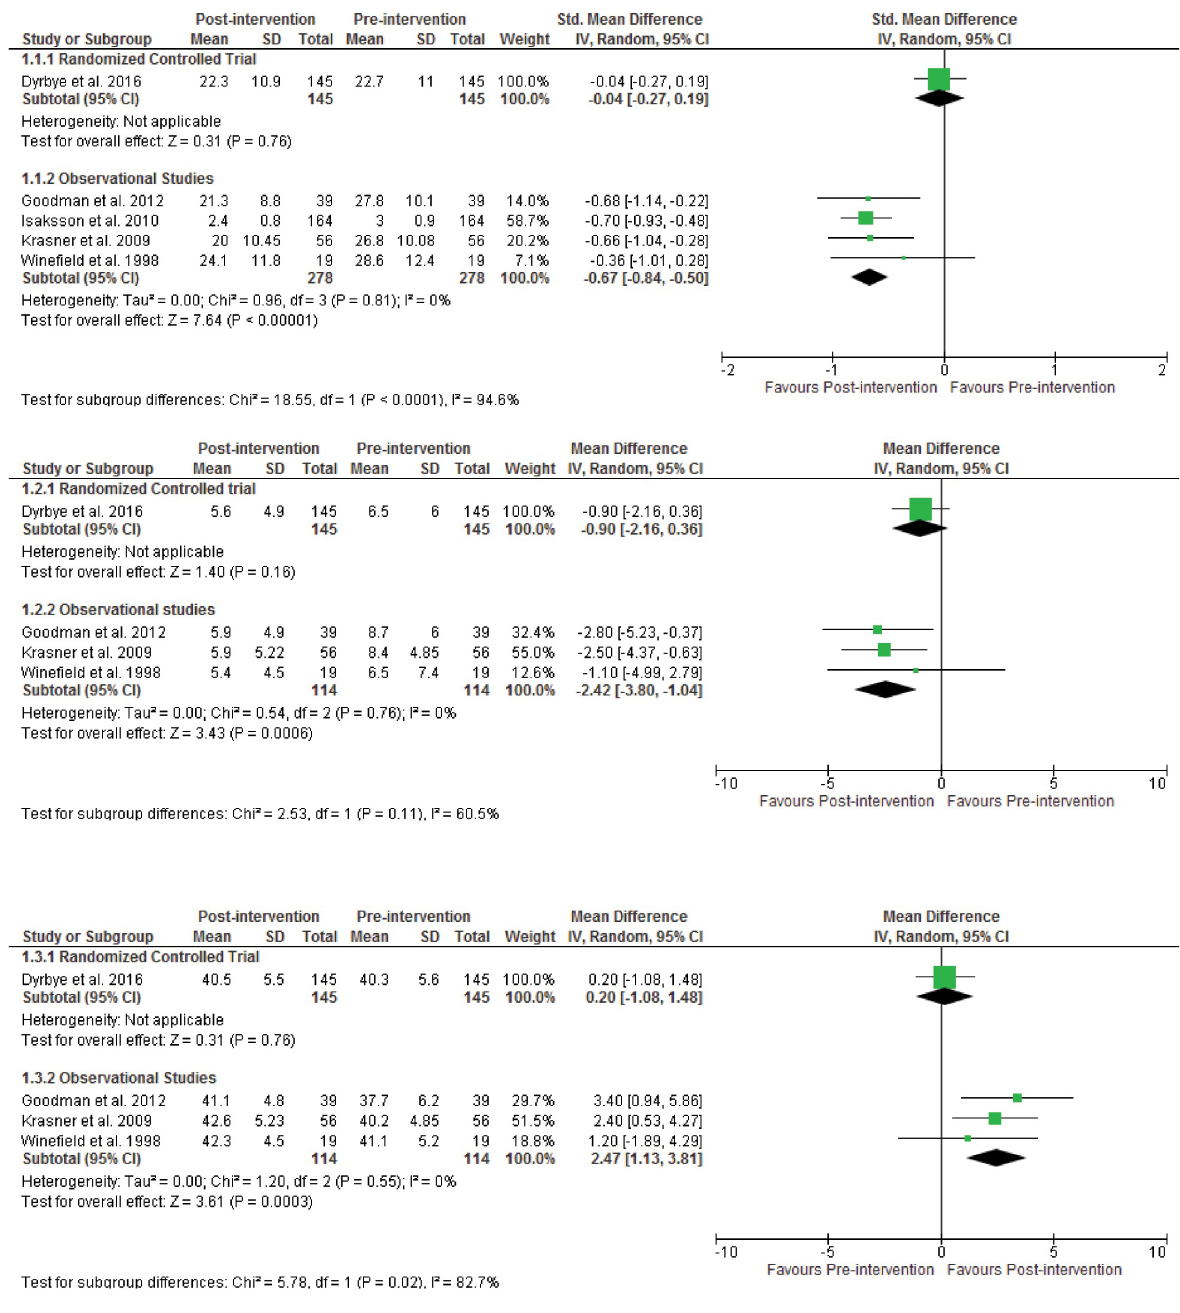
Fig 2. a. Pooled between-group differences in emotional exhaustion scores (burnout). b. Pooled between-group differences in depersonalization scores (burnout). c. Pooled between-group differences in personal accomplishment scores